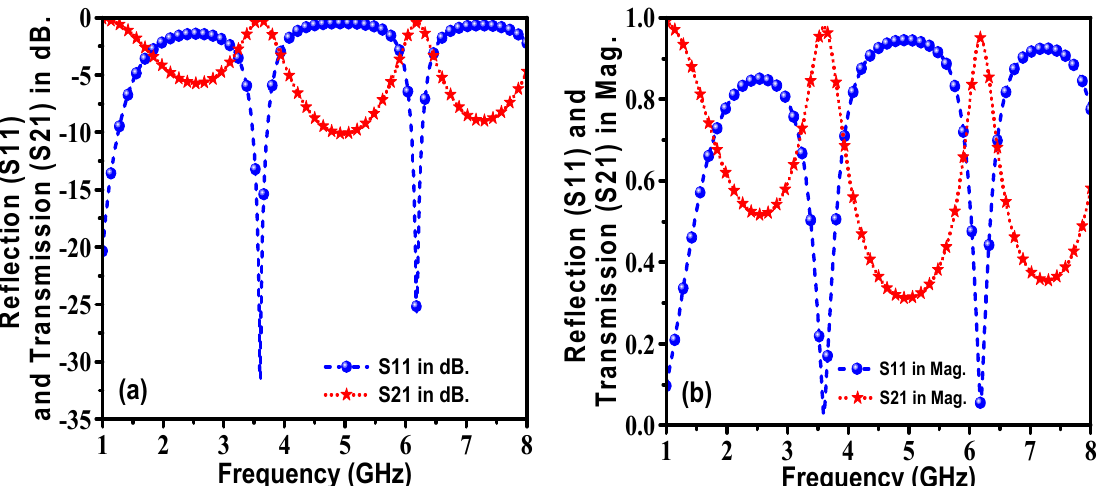
Figure 6. Simulated results of the reflection and transmission coefficients for the proposed corona-shaped sensor when the sensor layer was filled with air: ( a ) in dB and ( b ) in magnitude.